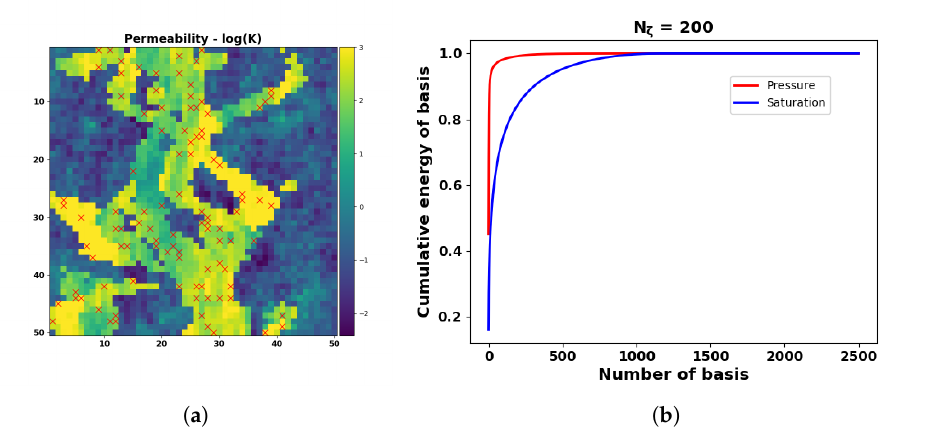
Figure 32. ( a ) Training samples randomly chosen for basis coefficient prediction. ( b ) Cumulative energy of eigenvalues for pressure (red) and saturation basis